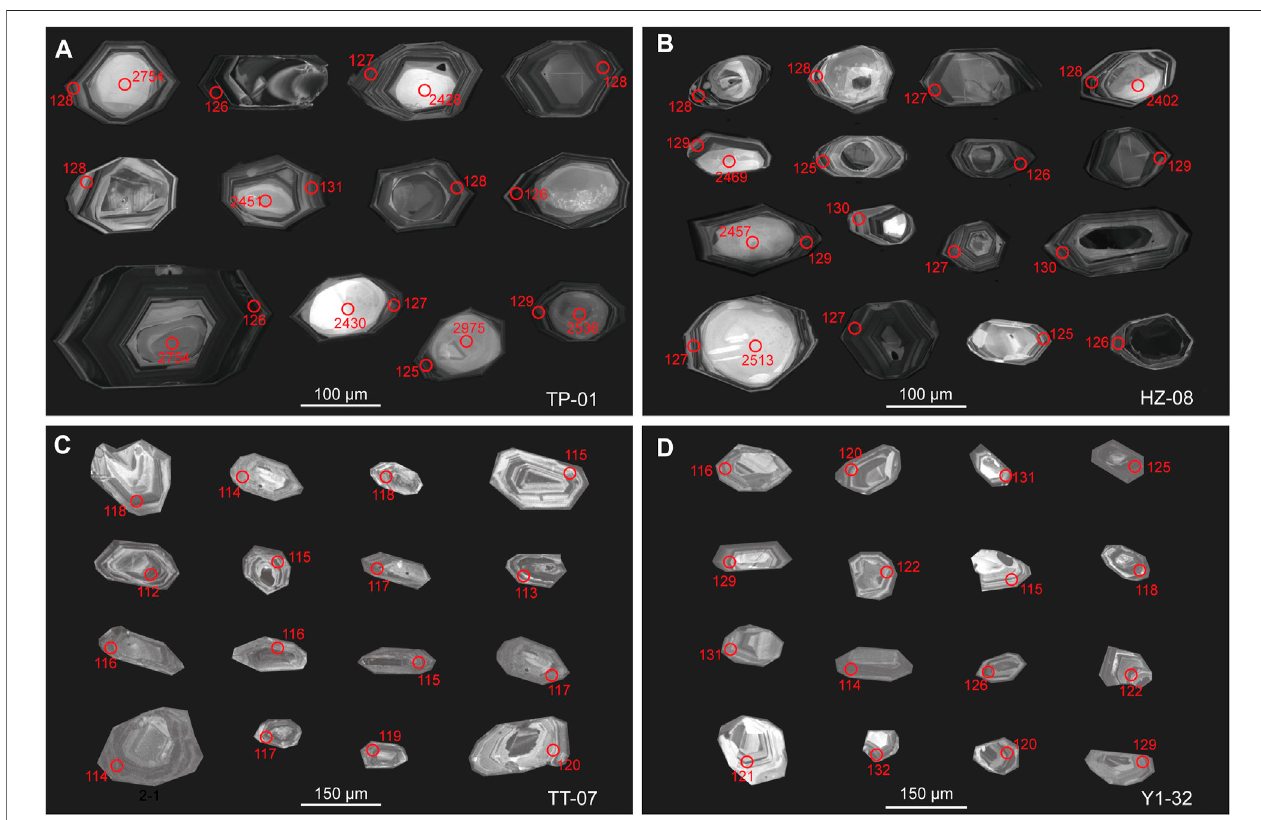
FIGURE 4 | Representative zircon CL images for the Huaibei-Linhuan intrusive rock samples: (A) Taiping diorite (TP-01); (B) Haizi diorite porphyry (HZ-08); (C) Qingdong microgabbro (TT-07); (D) Yuandian-1 dolerite (Y1-32).